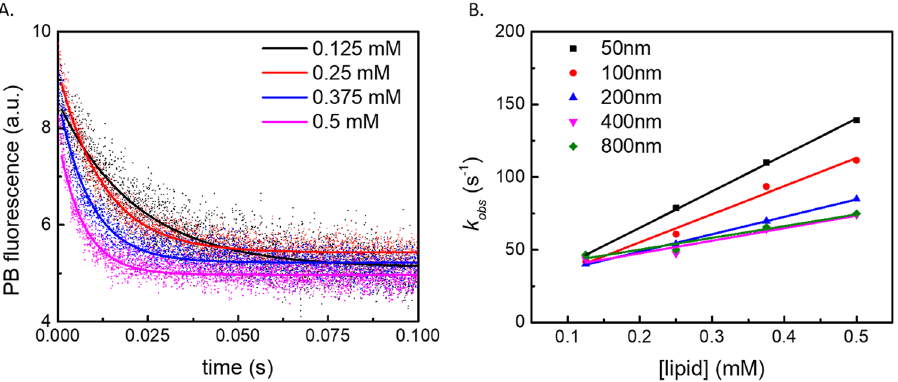
Figure 2. k obs values for ENB binding experiments are different for LUVs of different sizes. (A) The PB fluorescence change after mixing 1 µM ENB with 50 nm LUVs of different concentrations. The signal decay rate increases as the concentration of LUVs increases as predicted by Eq. (2). The data shown resulted from averaging 10–25 consecutive measurements, as described in the “Materials and methods” section. (B) The relation between k obs and lipid concentration for LUV samples of different sizes obtained through extrusion through filters with pore sizes indicated in the legend. k obs and [lipid] follow a linear relation as predicted by Eq. (3). The slope, which denotes k on , increases as the size of the LUVs decreases. Error bars are the standard errors from the exponential fitting in (A) , which are smaller than the symbol size. (B) shows the results from a single vesicle